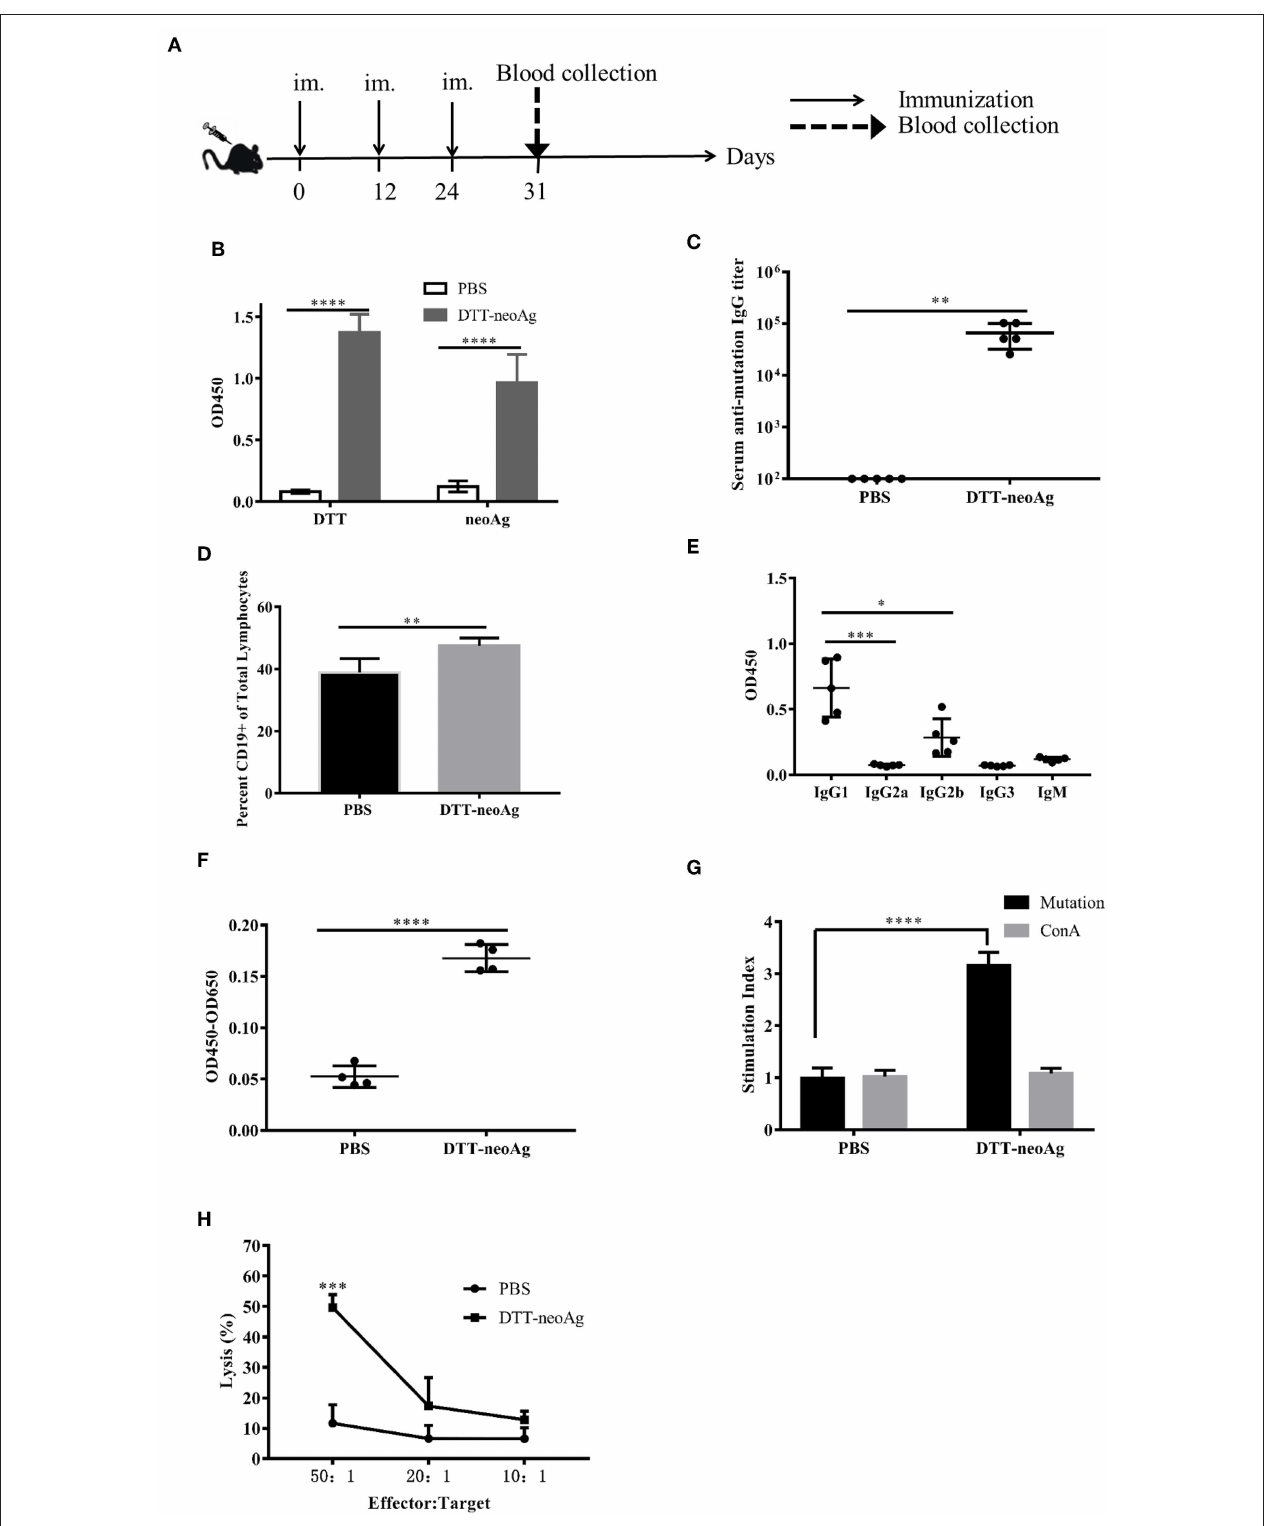
FIGURE 2 | DTT-neoAg induces neoantigen-specific antibodies and antitumor cellular immune responses in mouse. The statistical significances were determined by Student’s T test. **** P < 0.0001; *** P < 0.001; ** P < 0.01; * P < 0.05. (A) A schematic diagram of the experimental design. (B–D) Female C57BL/6 mice ( n = 5) were immunized subcutaneously on day 0, 12, 24 with DTT-neoAg vaccine. One week after the third immunization, mouse sera were collected by orbital blood sampling,